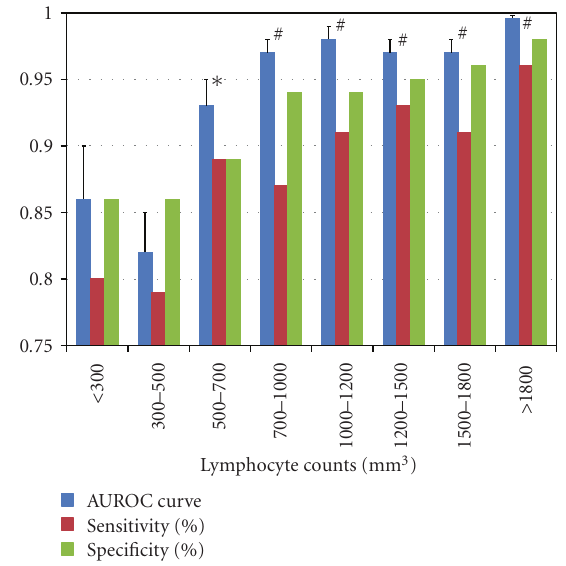
Figure 3: Analysis of area under the receiver operating charac- teristic curves for lymphocyte-stratified patients groups. AUROC: area under the receiver operating characteristic. Error bar; standard error. ∗ : P < . 05 versus < 300/mm 3 category and P < . 05 versus 300– 500/mm 3 category. # : P < . 05 versus < 300/mm 3 category, P < . 05 versus 300–500/mm 3 category, and P < . 05 versus 500–700/mm 3